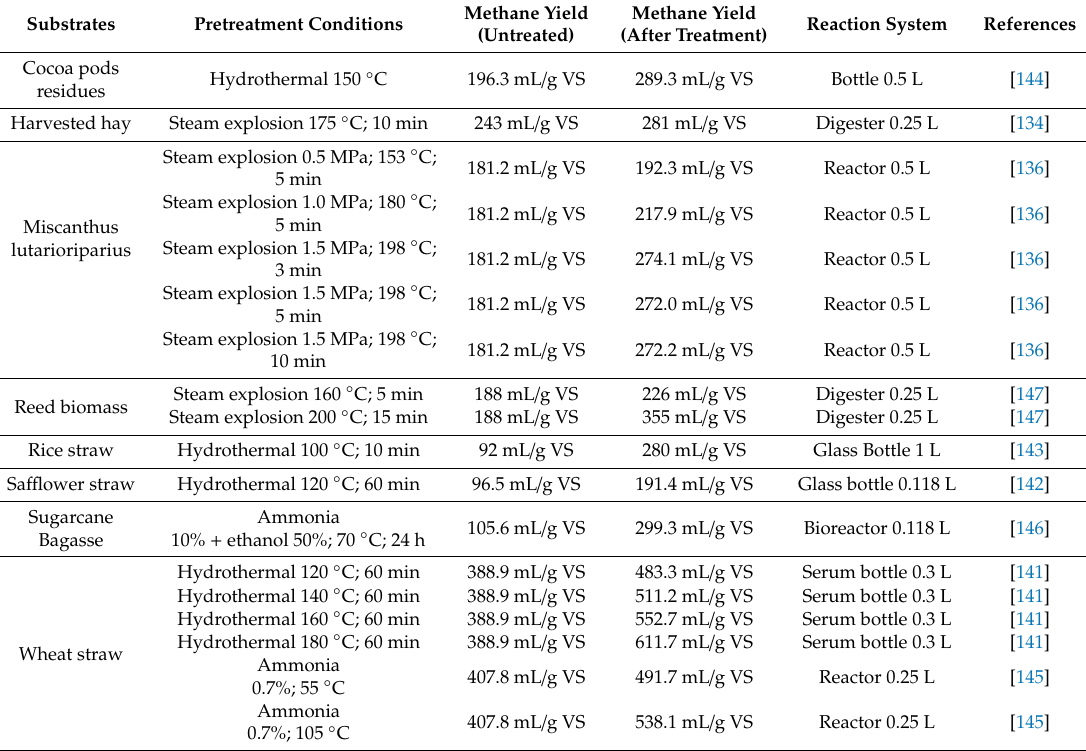
E ff ect of di ff erent physicochemical pretreatments on methane yield from di ff erent lignocellulosic